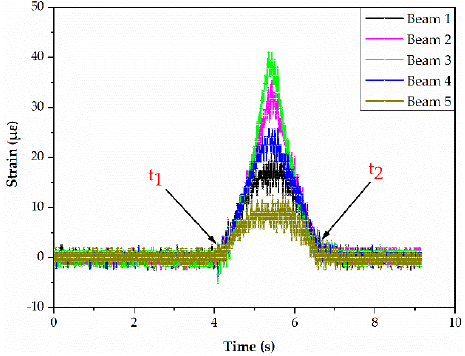
Figure 14. Measured strain time history curve.